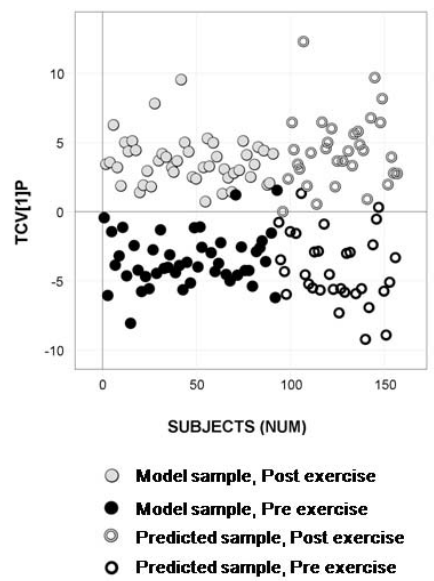
Figure 4. Longitudinal sample predictions in the classification model for subset selection 1- metadata. OPLS-DA predictive score plot of the model updated with the remaining samples from exercise occasion one and two showing separation between pre- exercise (black circles) and post- exercise (gray circles) serum samples (Class prediction (CV): 97.8%). Predicted test samples from exercise occasions three and four marked as open circles display high predictive classification accuracy (Class prediction (Test set): 96.9%) for pre- exercise samples (black open circles) and post- exercise samples (gray open